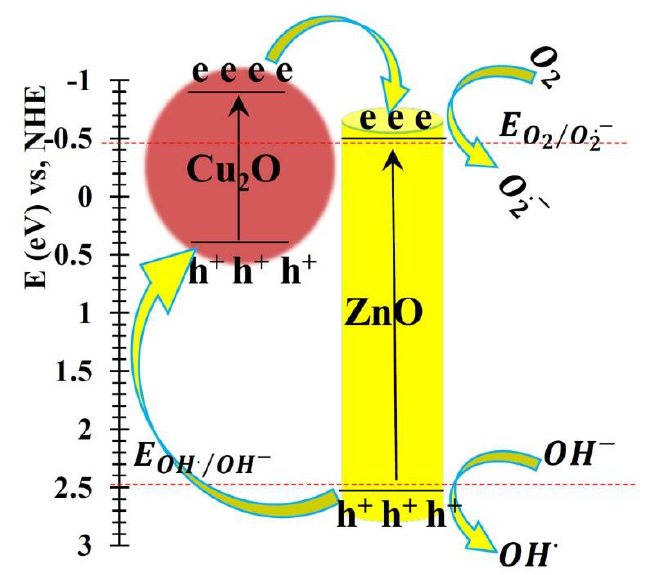
Fig. 8. Type II charge transfer processes for the photocatalytic activity of the ZnO- Cu2O